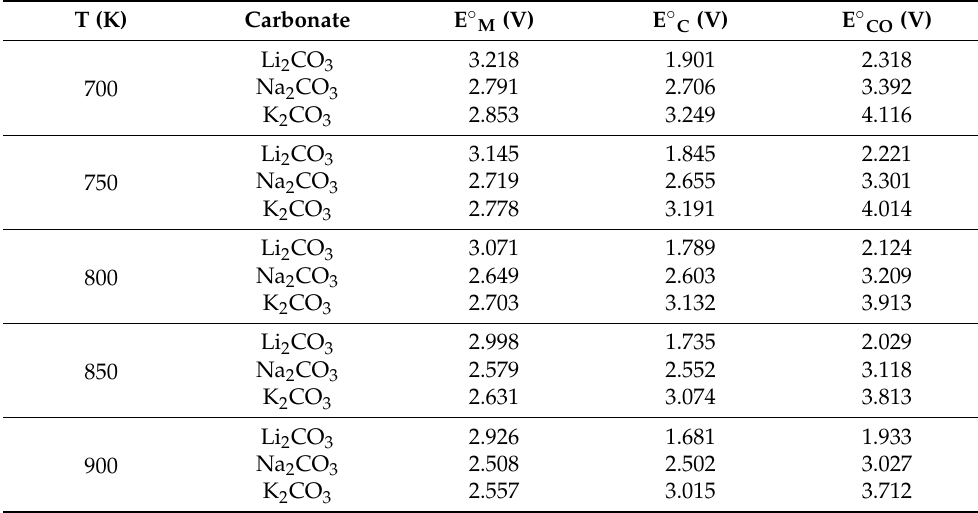
Table 1. Standard potentials for the conversion of alkali metal carbonate to pure alkali metal, carbon, and carbon dioxide (Li 2 CO 3 , Na 2 CO 3 , or K 2 CO 3 at different temperatures). T(K)